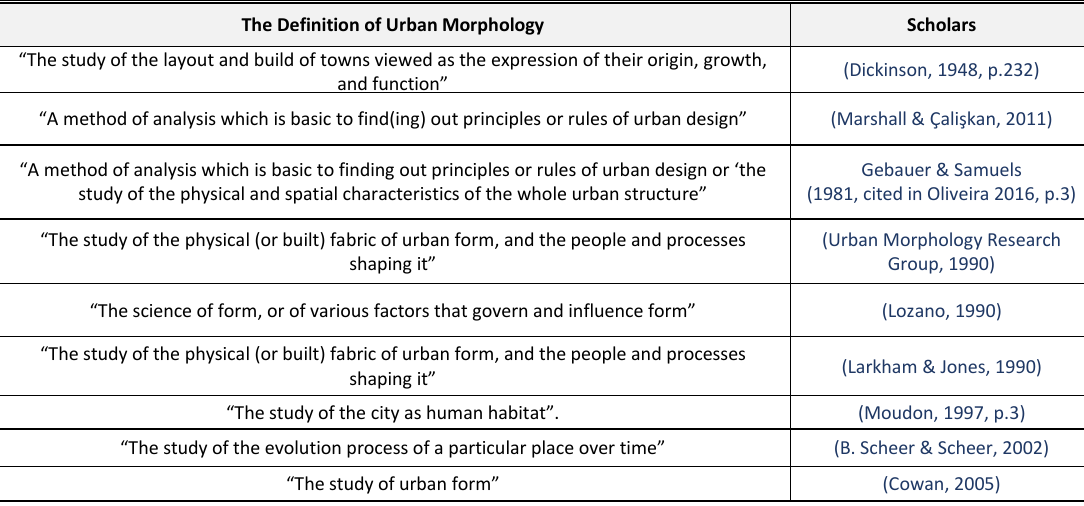
Table 1 Definitions of urban morphology by